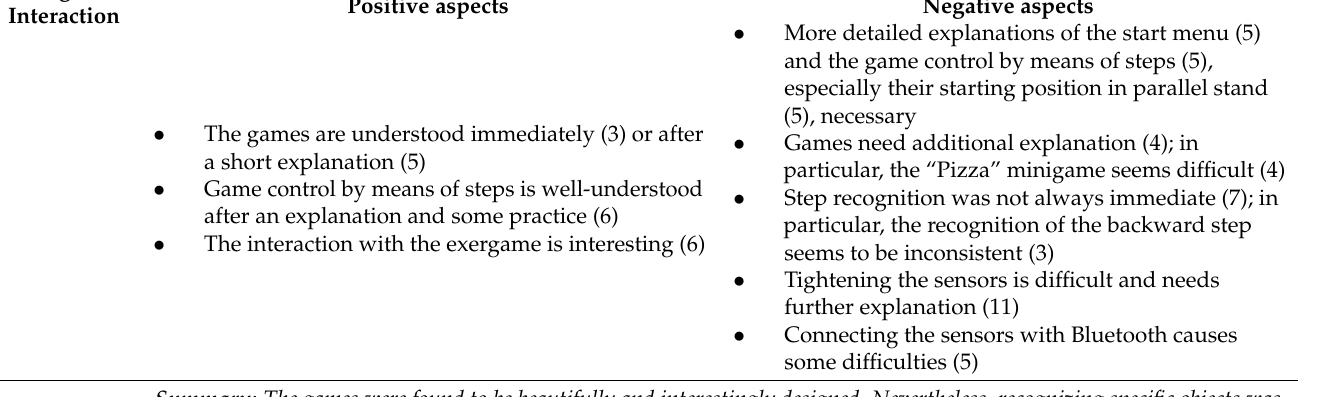
Table 2. Summary of usability protocol with supervisors’ observations and participants’ feedback. VITAAL